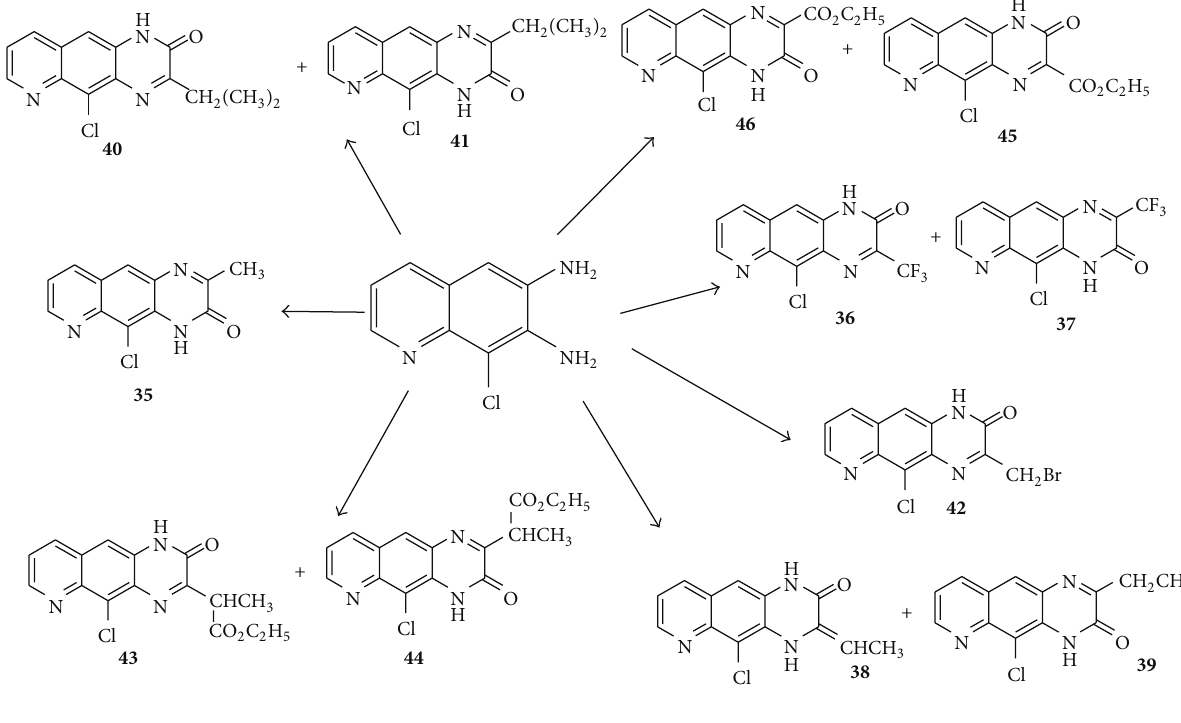
Figure 12: Chemical structures of compounds tested.